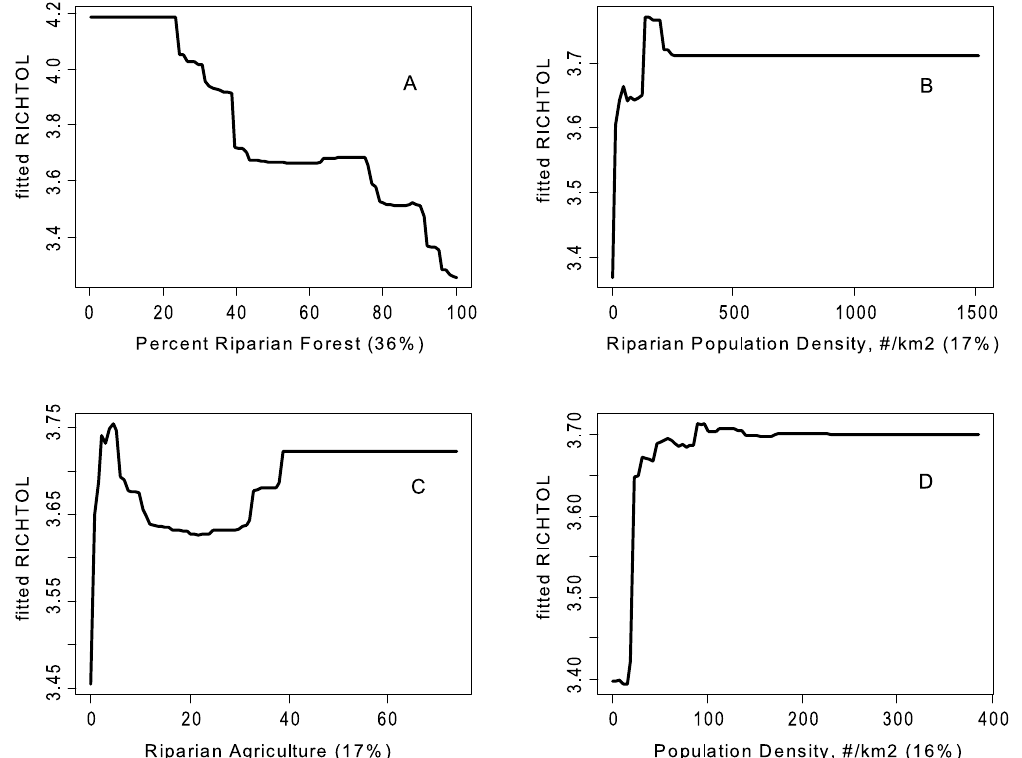
Figure 3. Partial dependency plots for variables in BRT model for RichTOL for North Central Appalachian Region. Boosted regression tree partial dependency plots show the response form of average taxa tolerance (y-axis = fitted function of RichTOL) based on the effect of individual explanatory variables with the response of all other variables removed (development data set). Shown in order of model importance: (A) percent riparian forest, (B) riparian population density ( # /km 2 ), (C) percent riparian agriculture and (D) population density ( # /km 2 ). The relative contribution of each explanatory variable is reported in parentheses. Refer to Table 1 for variable definitions. Three of the four variables can be interpreted as disturbance variables, two directly assessing urban land use (population density) and the third, riparian forest, which measures the amount of disturbance in the riparian zone was the top variable modeled. However, this region had the shortest disturbance gradient and the lowest modeled R 2 (0.67), though still relatively strong.